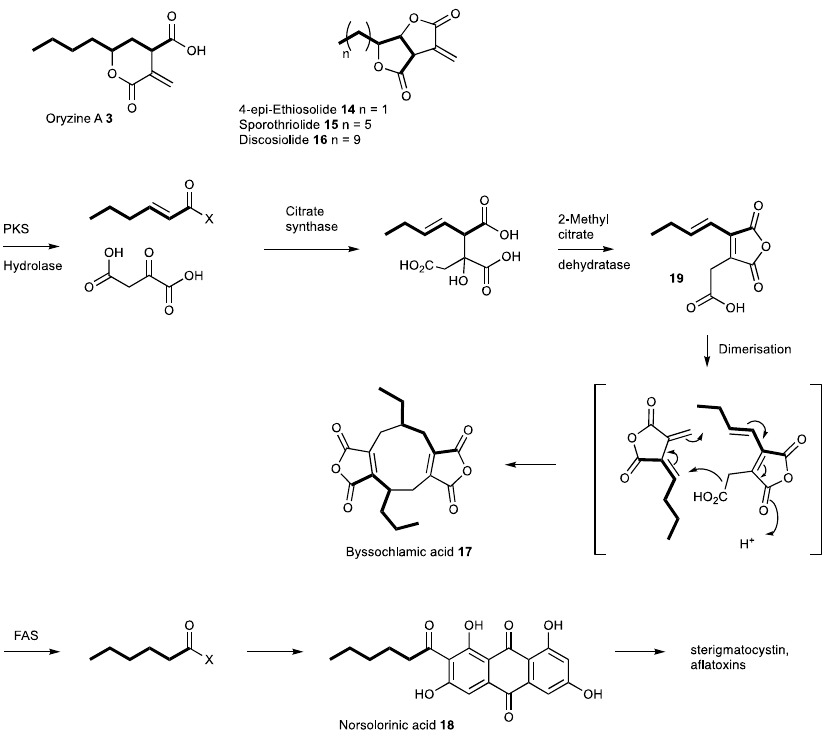
Figure 5. Compounds biosynthetically related to 3 .